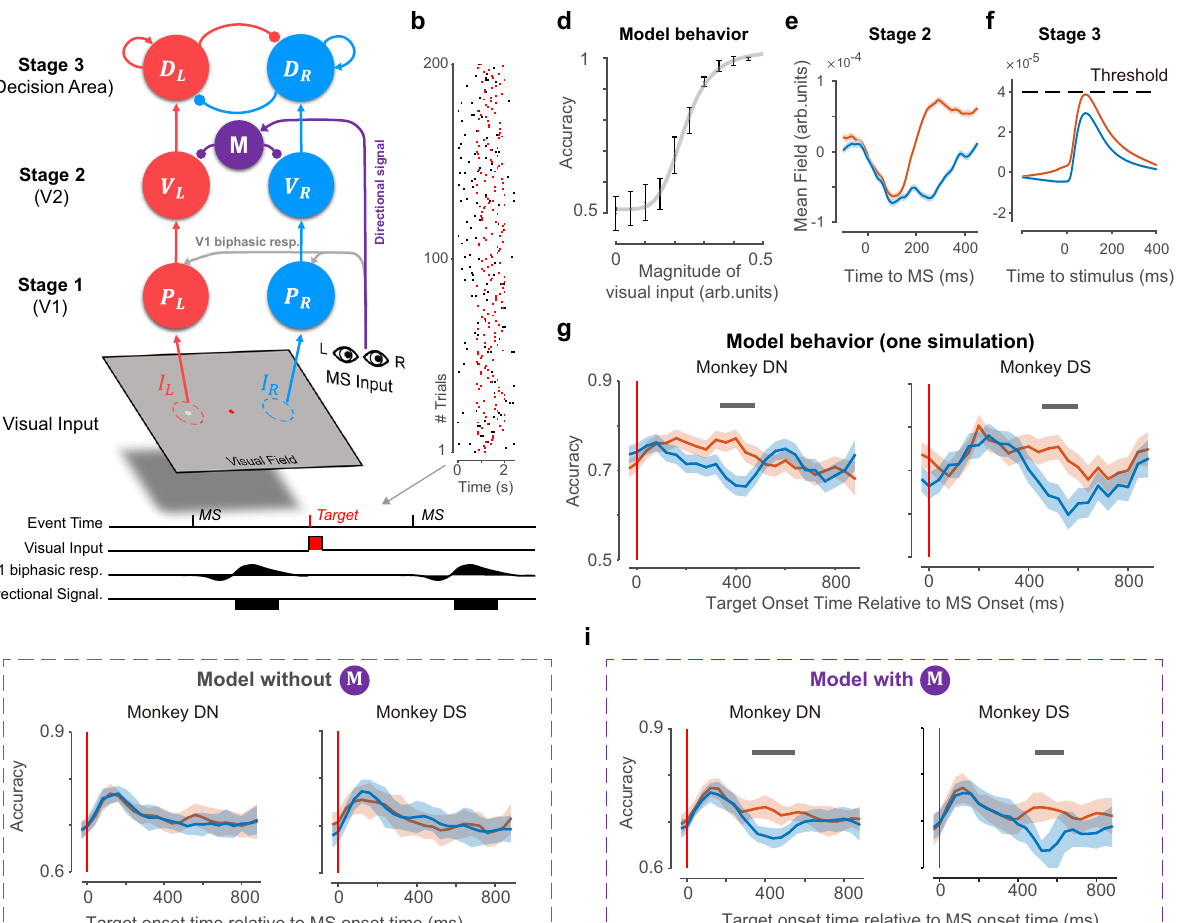
the real data in Fig. 1. f Model response (mean±s.d.) from D around target onset acrosstrialsinwhichtargetsappeared0.16~0.4safterthepreviousmicrosaccades. g Simulated behavior accuracy (mean±s.d.) as a function of microsaccade-target interval by using microsaccade statistics and target location information from the realexperimentaldata ofmonkey DN(leftpanel) ormonkey DS (right panel). Gray bars indicate period with signi fi cant differences between the two conditions (one- sided percentile method of bootstrap test with Bonferroni corrections, p <0.05). monkey compose one simulation). i Simulated behavior accuracy (mean±s.d.) of the full model across 15 simulations. Gray bars indicate period with signi fi cant differencesbetweenthetwoconditions(one-sidedpercentilemethodofbootstrap test with Bonferroni corrections, p <0.05). Source data are provided as a Source Data fi